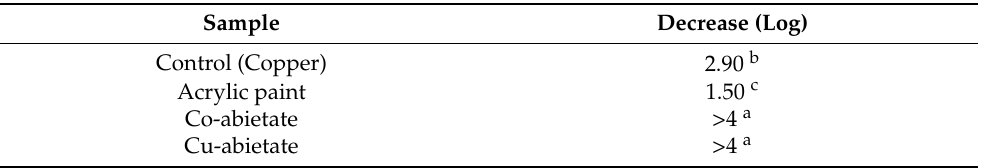
Table 3. Decrease in viral load of plates coated with a paint containing Co-abietate and Cu-abietate determined in antiviral testing using an adaptation of the ISO 21702:2019